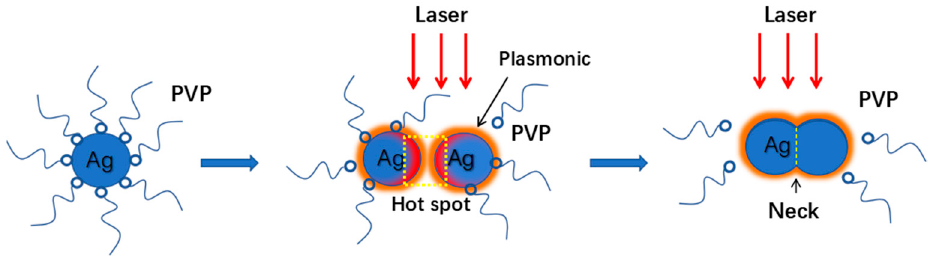
Figure 3. Schematic of laser sintering of PVP capped Ag NPs.